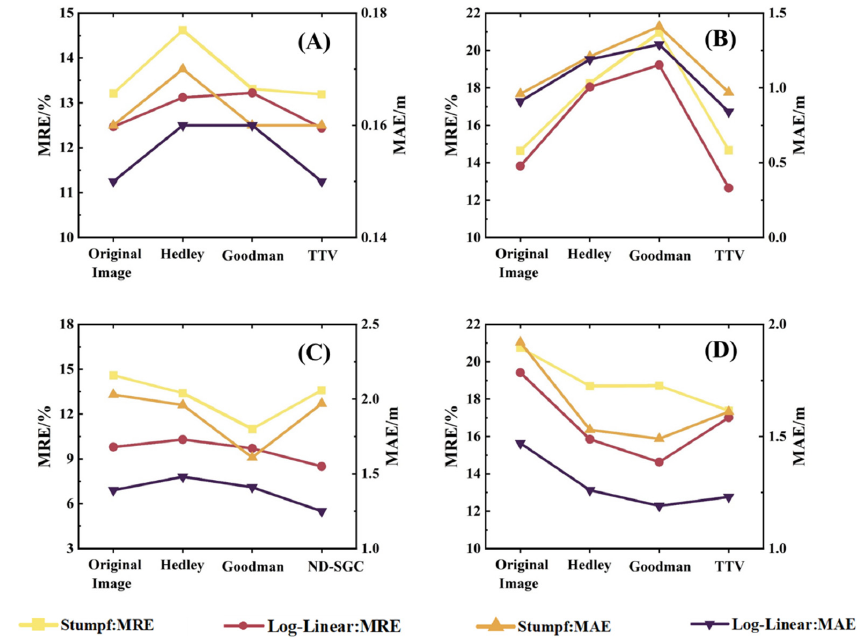
Figure 6. Water depth inversion accuracy of uncorrected images and images corrected by three sun glint correction models. ( A ) Taiping Island; ( B ) Tiexian Jiao; ( C ) Dongdao Island (11–20 m); ( D ) Dongdao Island (2–20 m).